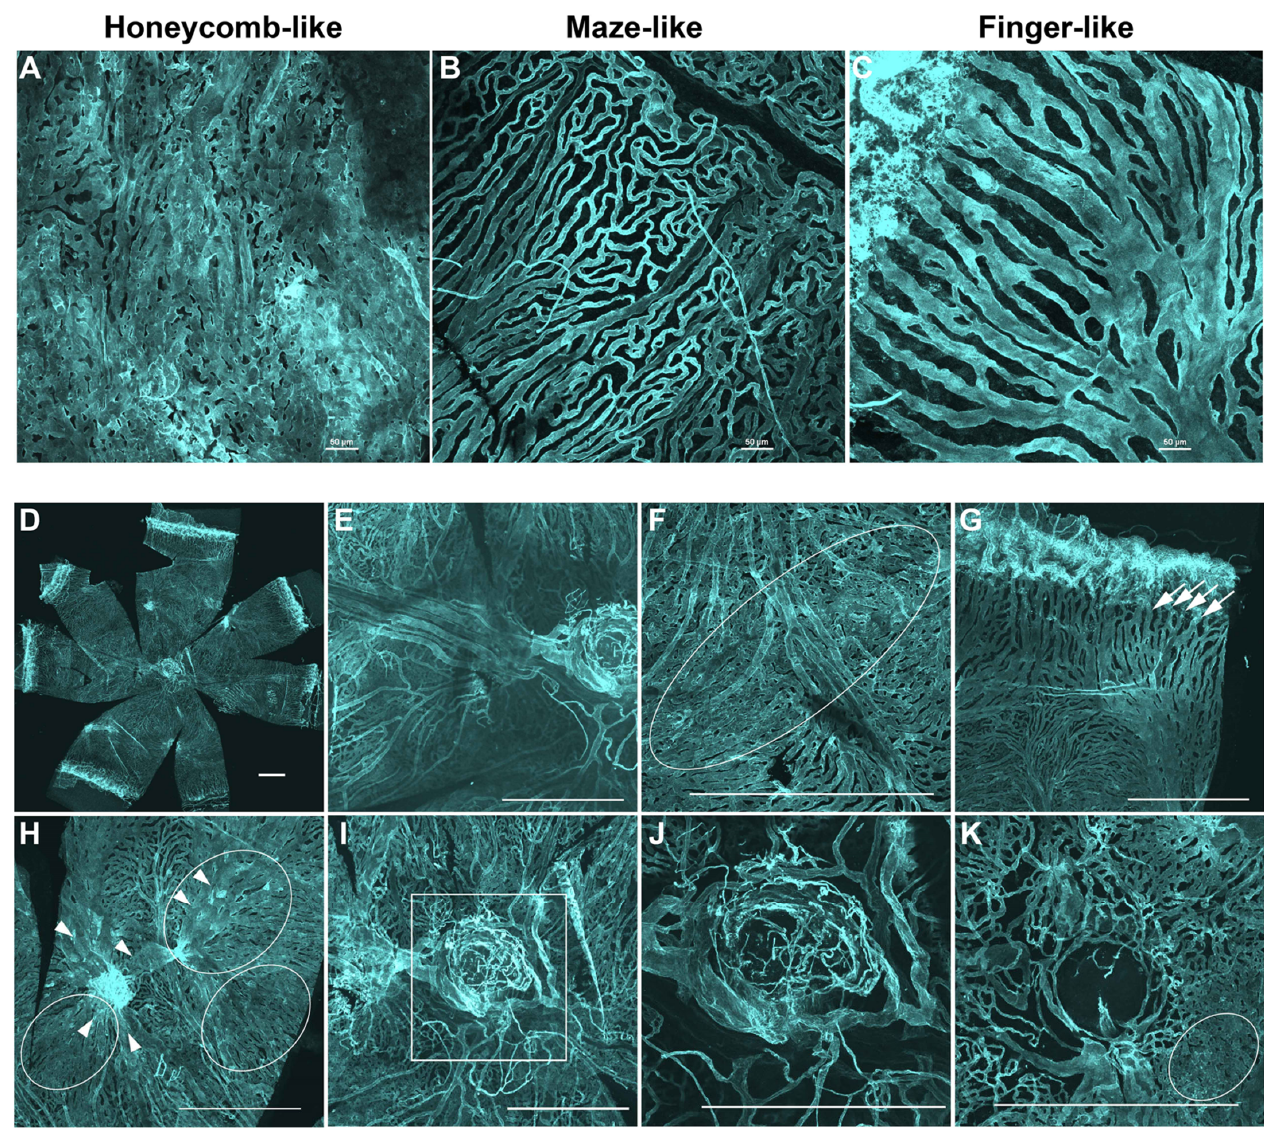
Figure 2. Visualization of the choriocapillaris and veins in the mouse choroid. The choriocapillaris display three different patterns, including the honeycomb ‐ like pattern ( A ), the maze ‐ like pattern ( B ), and the finger ‐ like projections pattern ( C , D ). Low magnification image of the whole choroidal vasculature of 6 ‐ week ‐ old FVBN mouse. ( E ) High magnification of choroid vasculature that includes the optic disc, the posterior pole, and part of the equator. Other high ‐ magnification images of the choroid show the choriocapillaris in the equator away from the vortex veins ( F ), periphery ( G ) and equator with the vortex vein ( H ), and optic disc area ( I – K ). Inset in I was focally dissected to separate the large blood vessels ( J ) from the choriocapillaris ( K ). The honeycomb ‐ like pattern observed in the middle of the equator, in the vicinity of the tributaries of the vortex vein, and on one side of the optic disc ( F , H , K ; oval shapes). Please note the tributaries of the vortex vein ( H ; arrowheads). The finger ‐ like projections pattern was observed in the periphery ( G ; arrows). The maze ‐ like pattern was observed in the equator ( F ), mid ‐ periphery ( G ), and in the peripapillary areas ( K ). Tissues were stained using anti ‐ podocalyxin antibody. Number of choroids examined = 14. All representative images were from 6-week-old FVBN mice and captured using confocal microscopy. Scale bars: 50 ( A – C ) and 500 µ m ( D – K